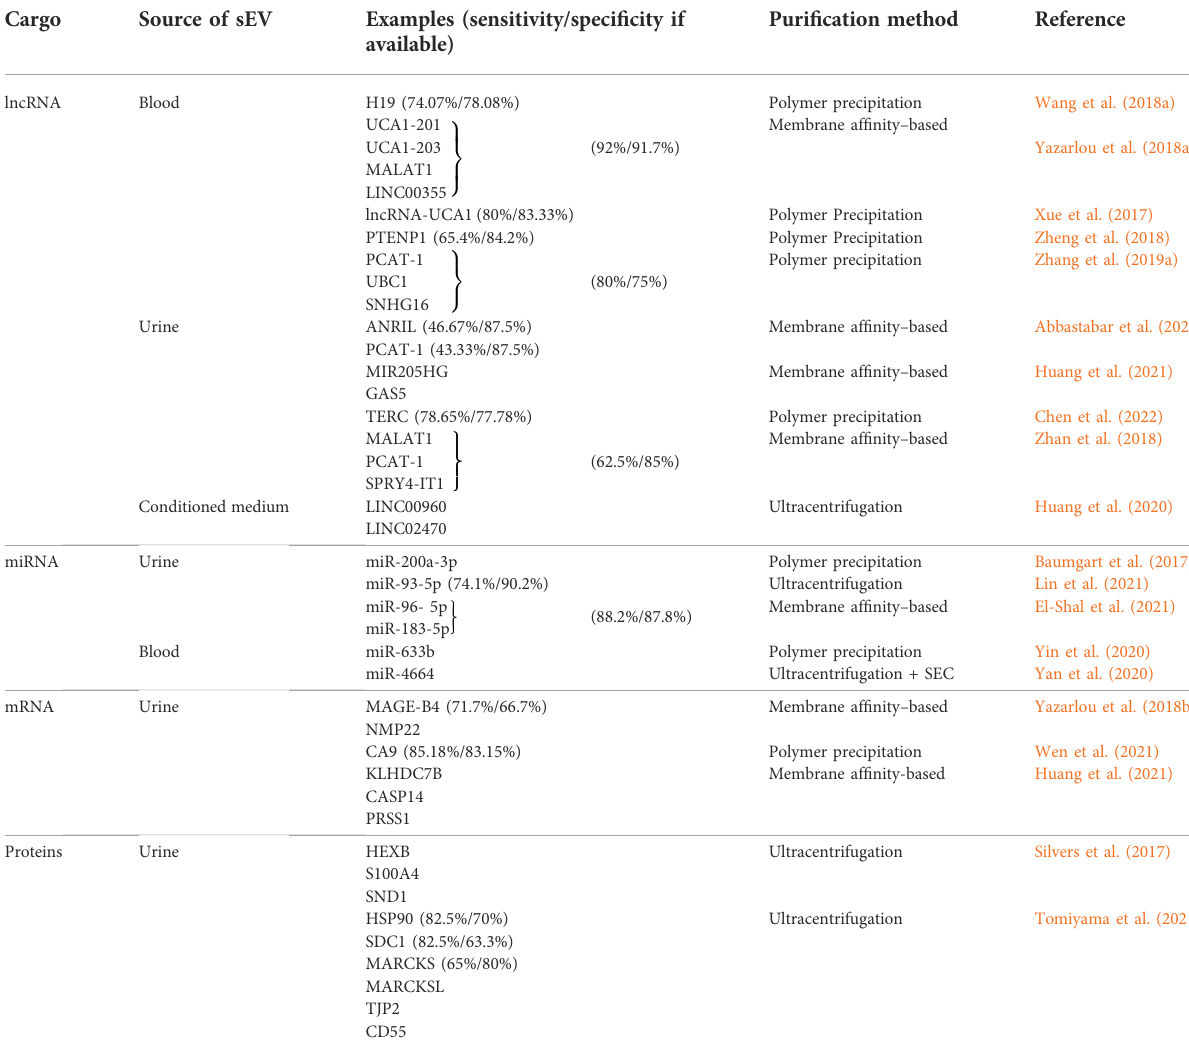
TABLE 2 Summary of the recently evaluated small extracellular vesicle cargo as potential biomarkers for urinary bladder carcinomas. sEVs – small extracellular vesicles, miRNA – microRNA, mRNA – messenger RNA, circRNA – circular RNA, lncRNA – long non – coding RNA, SEC – size exclusion